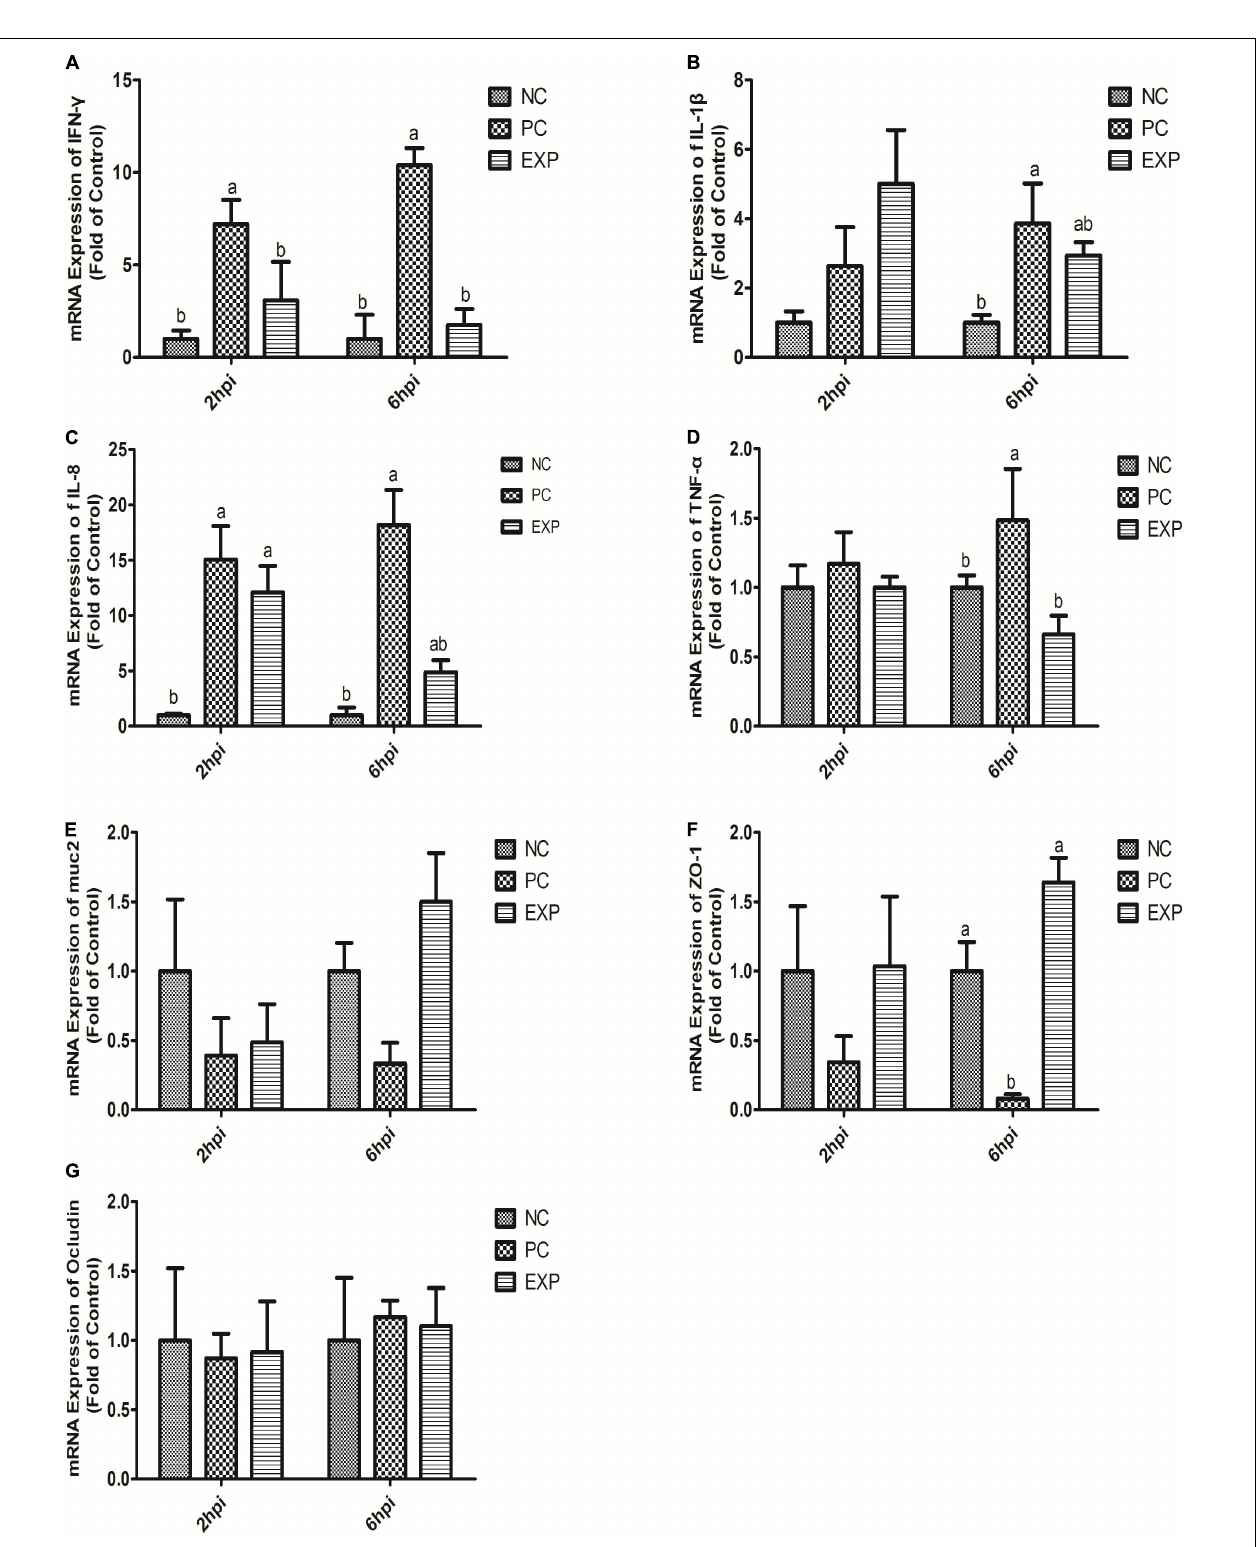
FIGURE 3 | Expression level of cytokines (IFN- γ , IL-1 β , IL-8, and TNF- α ), muc2 mucin and the tight junction proteins (ZO-1 and Occludin) (A–G) in intestinal epithelial cells were estimated by real-time PCR. The bars represent the mean ± SD ( n = 6/group). Different letters over the bars indicate statistically differences between the groups ( P < 0.05), same letters over the bars indicate no statistically differences between the groups ( P > 0.05). NC, the negative control group; PC, the positive control group; EXP, C. butyricum + S. enteritidis treatment.